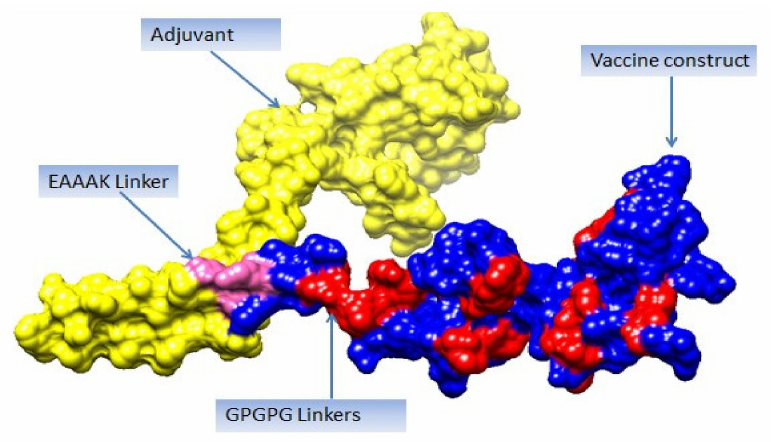
Figure 5. Vaccine 3D structure. Yellow color represents adjuvant (cholera toxin B subunit), blue color shows vaccine construct, and pink color represents EAAAK linker, while red color represents GPGPG